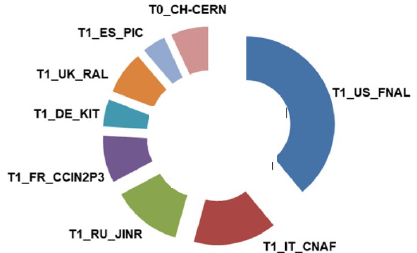
Fig. 1. Number of events processed for good jobs in percentage from 2015-04-01 to 2018-05-31 at all WLCG Tier1 sites for CMS